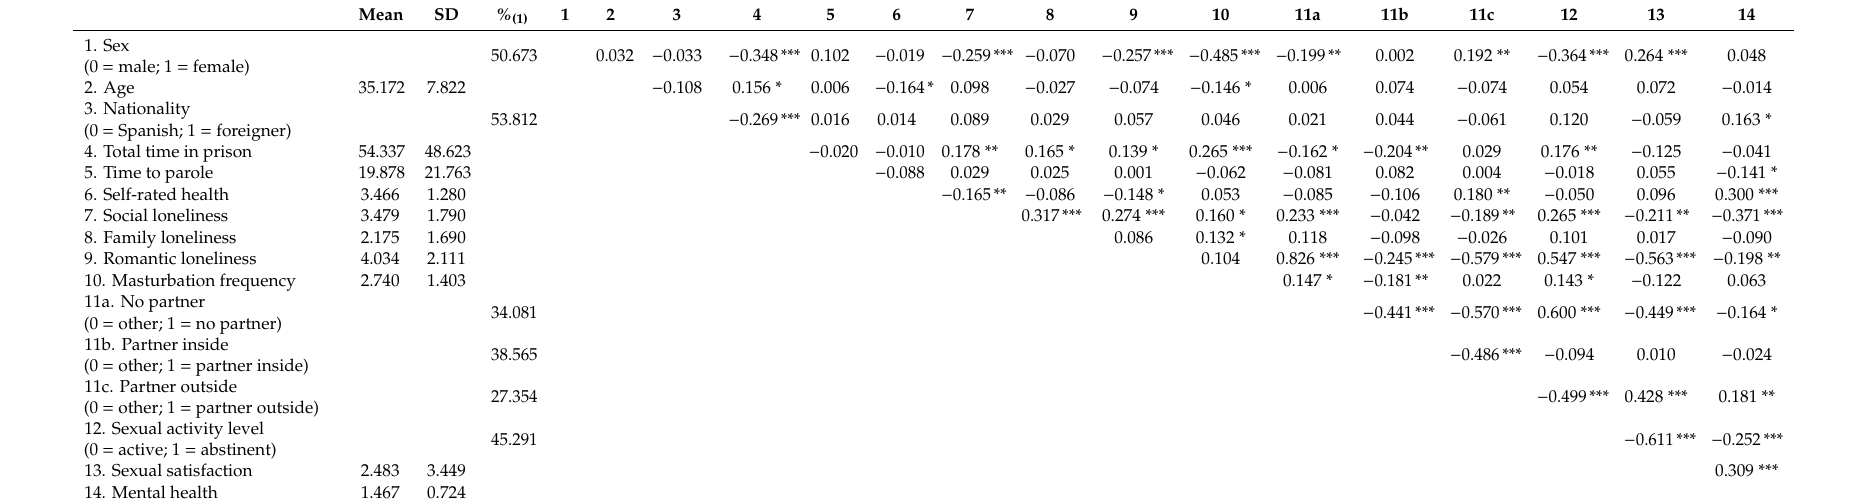
Table 1. Correlations, means, and standard deviations of the variables considered in this